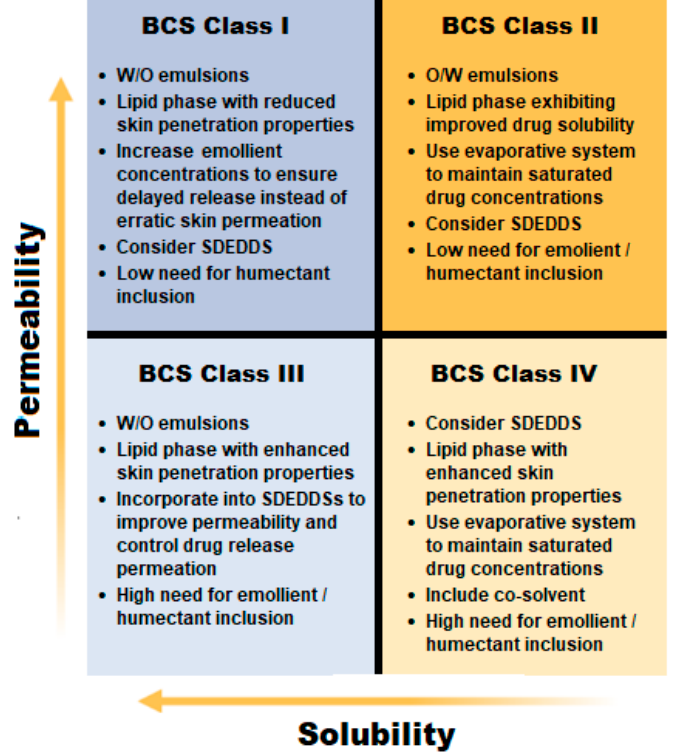
Figure 5. Formulation recommendation system (FRS) when considering drugs belonging to different biopharmaceutical classifications for incorporation into dermal spontaneous emulsions .